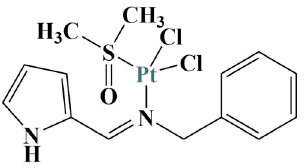
Figure 5. The most potent antiproliferative complex described in [28].